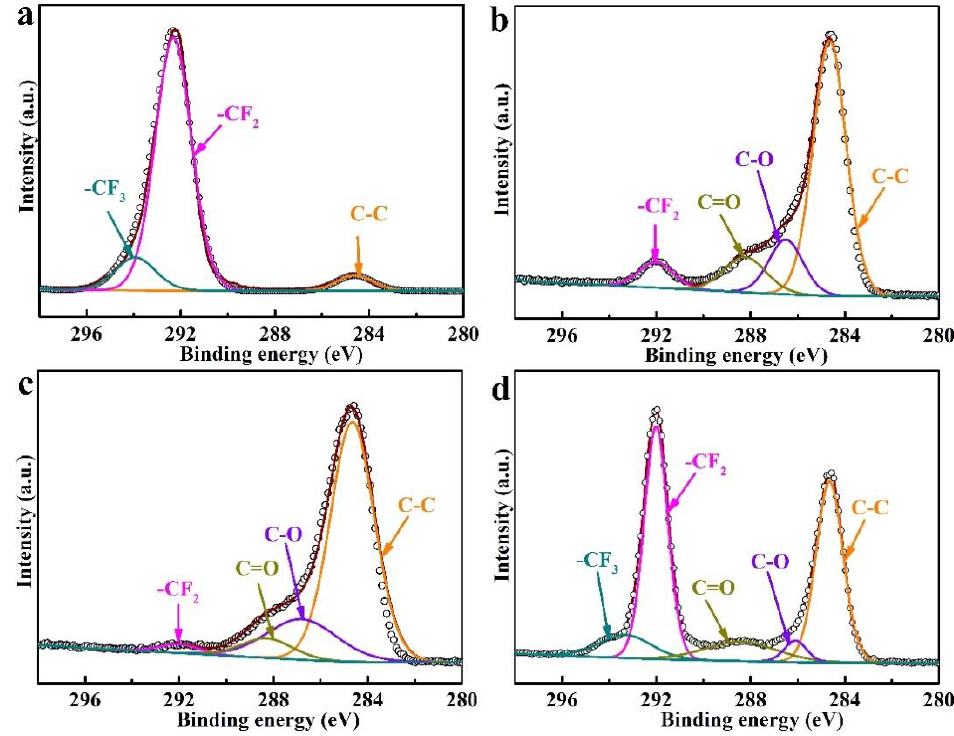
Figure 4. XPS C1s spectra of FEP films activated under different conditions: ( a ) FEP, ( b ) FEP-THF- 0.3 M-30 s, ( c ) FEP-DMI-0.9 M-30 min, ( d ) FEP-P.